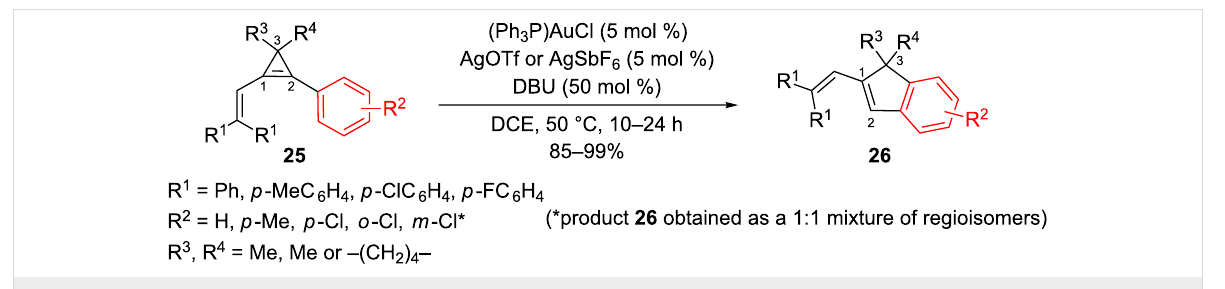
Scheme 12: Gold-catalyzed rearrangement of vinylcyclopropenes 25